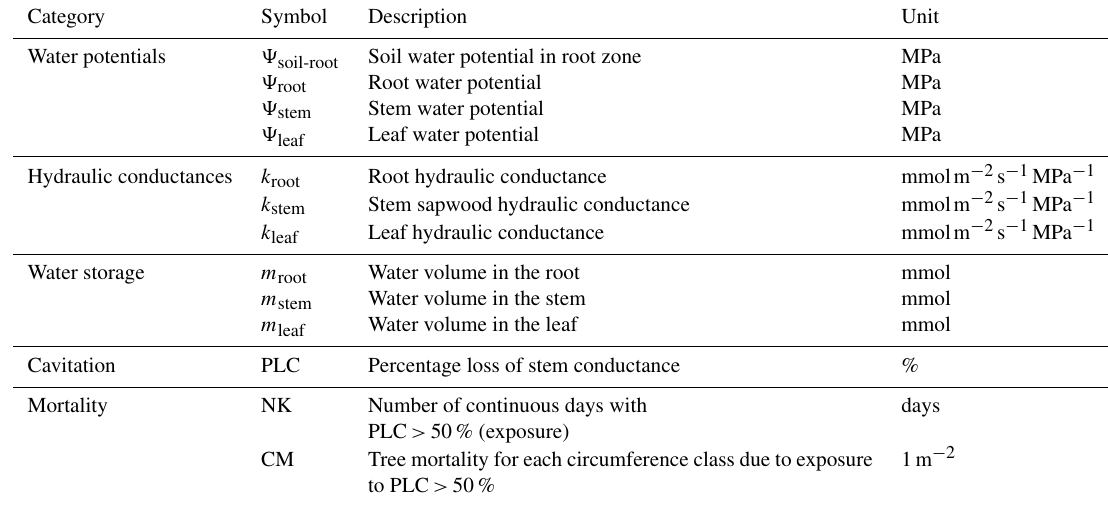
Table A3. Outputs variables calculated by